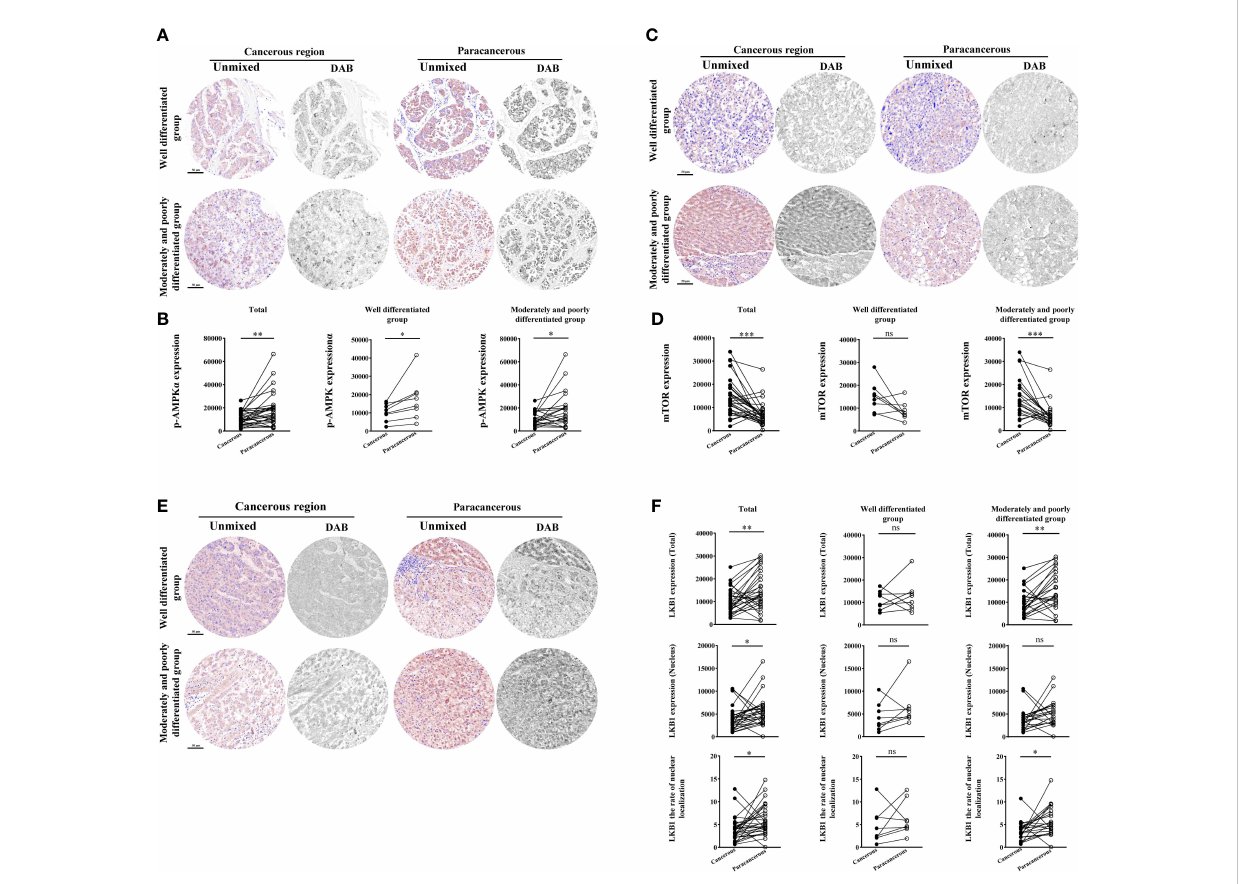
FIGURE 5 Immunohistochemical staining of p-AMPK, mTOR, and LKB1 proteins in liver cancer tissues and their quantitative images. (A) Representative image of immunohistochemical staining of the p-AMPK protein in liver tissues. (B) Quantitative multispectral image of the p-AMPK protein. (C) Representative image of immunohistochemical staining of the mTOR protein in liver tissues. (D) Quantitative multispectral image of the mTOR protein. (E) Representative image of immunohistochemical staining of the LKB1 protein in liver tissues. (F) Quantitative multispectral image of the LKB1 protein. The experimental data are expressed as the mean ± SEM. Compared to paracancerous regions, * p < 0.05; ** p < 0.01; *** p < 0.001. Scale bar, 50 µm. ns, not